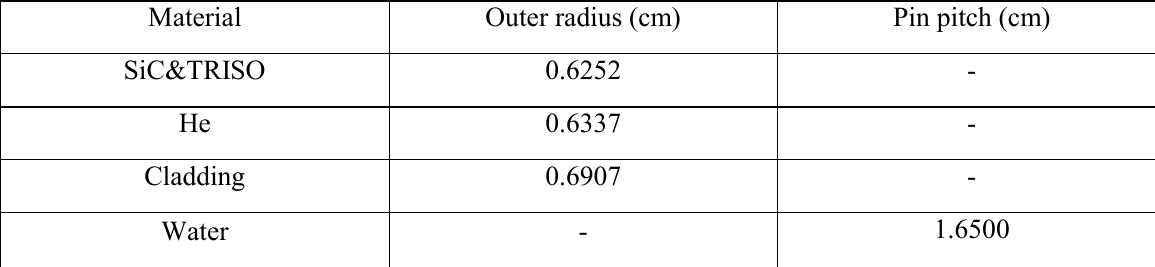
Table III Comparison of k